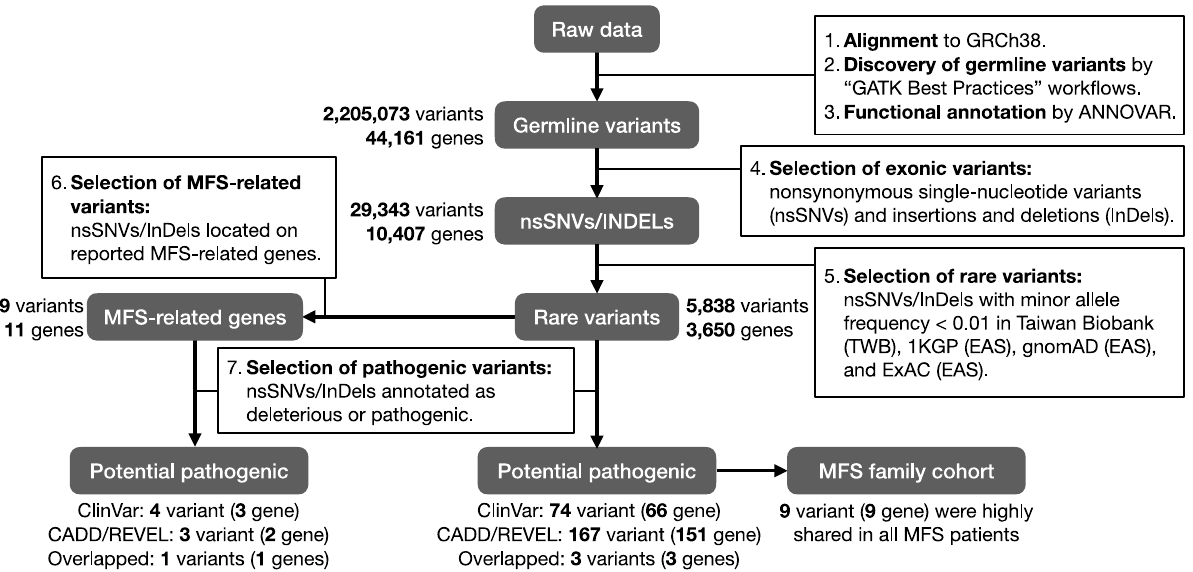
Figure 1. Study workflow of the MFS WES analysis.